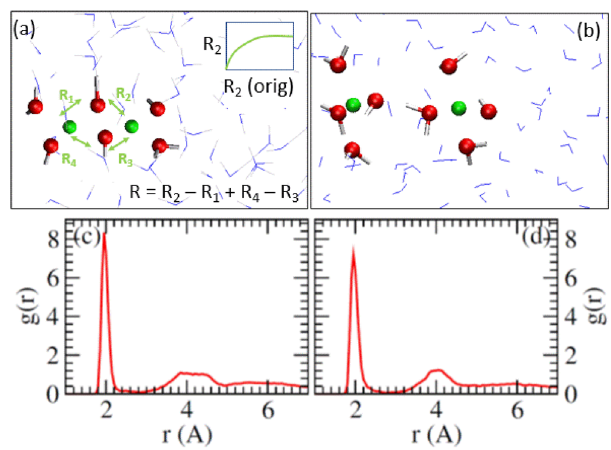
Fig. 2 Structural predictions. a AIMD snapshot of Cu 2 + dimer in pure water. b The dimer is mostly dissociated, with a H 3 O (cid:3) bridge linking the 2 ð r Þ between the Cu and O sites for panels ( a , b ), two Cu 2 + . c , d g Cu (cid:3) O respectively. In panel ( a ), the reaction coordinate R is also illustrated; the schematic in the insert indicates the renormalization of a Cu-O distance R 2orig into R 2 which is an integral part of R . A constraint is applied for panels ( b , d ); hence those results should be considered